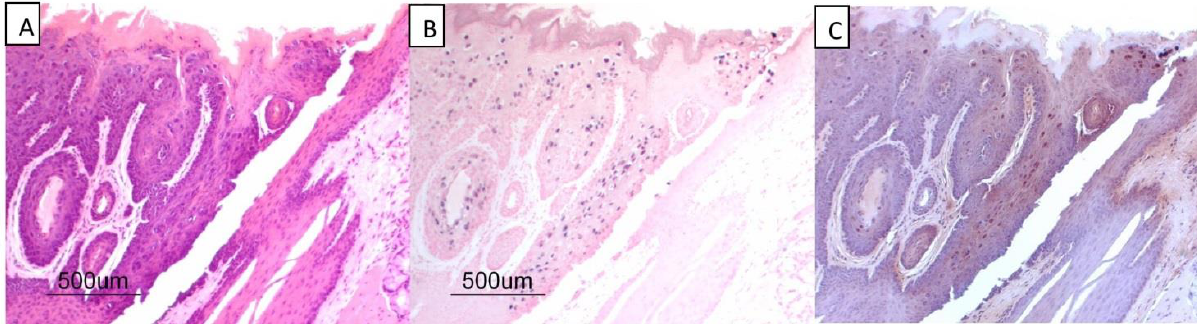
FIGURE 2: MmuPV1 secondary infections of the mouse oral cavity. (A) (H&E), (B) ( in situ hybridization using MmuPV1 DNA probe) and (C) (immunohistochemical staining using a monoclonal antibody to MmuPV-1 L1 protein) detecting an infection localized to the base of the tongue at the circumvallate papilla. (A) , (B) and (C) are successive 4 μm sections from formalin-fixed paraffin-embedded tissues from athymic mice. One of several examples of MmuPV-1 infection of the circumvallate papilla of the mouse